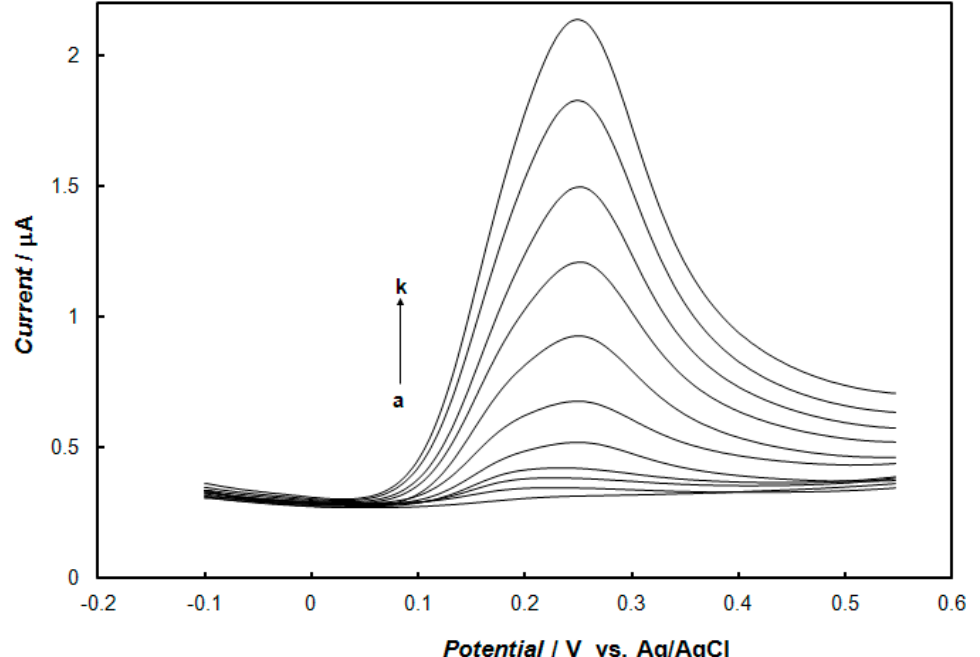
Figure 7. Square-wave voltammograms recorded at the gold electrode modified with the polypyrrole—MCM-48 nanocomposite in 0.1 M of phosphate buffer solution (pH 7.4) containing dopamine with concentrations: ( a ) 0 µ M, ( b ) 2 µ M, ( c ) 6 µ M, ( d ) 10 µ M, ( e ) 25 µ M, ( f ) 50 µ M, ( g ) 100 µ M, ( h ) 150 µ M, ( i ) 200 µ M, ( j ) 250 µ M, and ( k ) 300 µ M. Square wave amplitude was 25 mV, frequency was 25 Hz, and step potential was 4 mV.